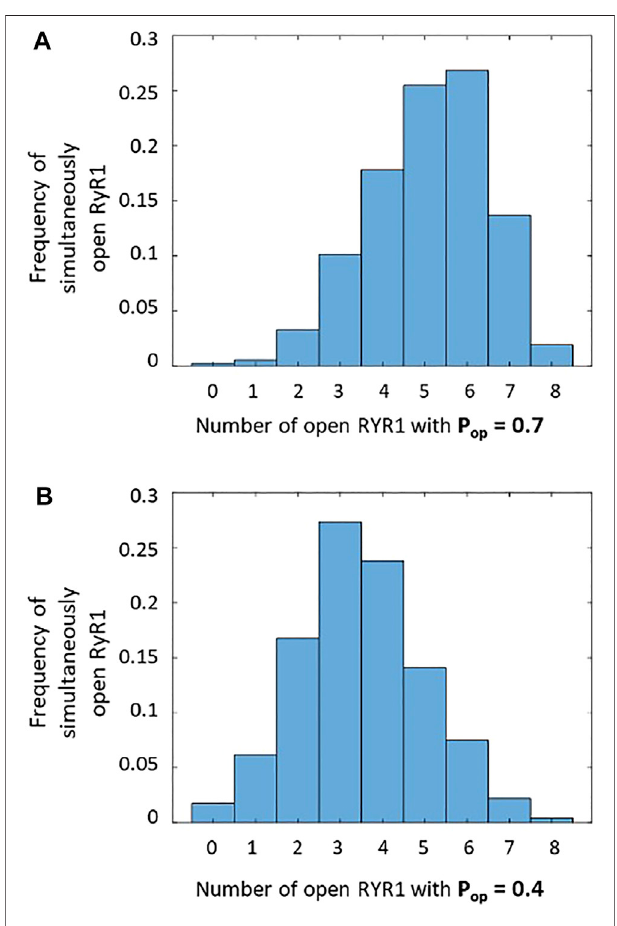
FIGURE 8 | Frequency of simultaneously open receptors in a cluster of eightRYR1 during 64 msthatcorresponds tothedurationofaCa 2+ spark (A) DuringasparkwhenRYR1aremaximallyactivatedbyNAADP,therearemost of the time around fi ve to six simultaneously open RYR1, with a single receptor open probability of 0.7 (Hohenegger et al., 2002). This is in agreement with the results seen in Figure 5 . (B) At basal NAADP concentration, the single receptor open probability is around 0.4, and there are continuously around three tofour simultaneously open RYR1, which isnot enough to reach the experimental Ca 2+ amplitude. In the two panels, the stochastic simulations of opening and closing of individual receptors are performed during 64